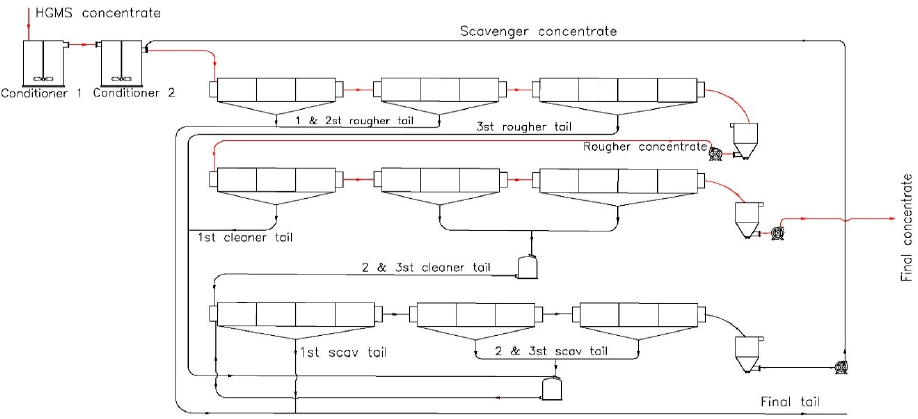
Figure 1. Simplified process flowsheet of the dephosphorization reverse flotation circuit in the Chadormalu processing plant.